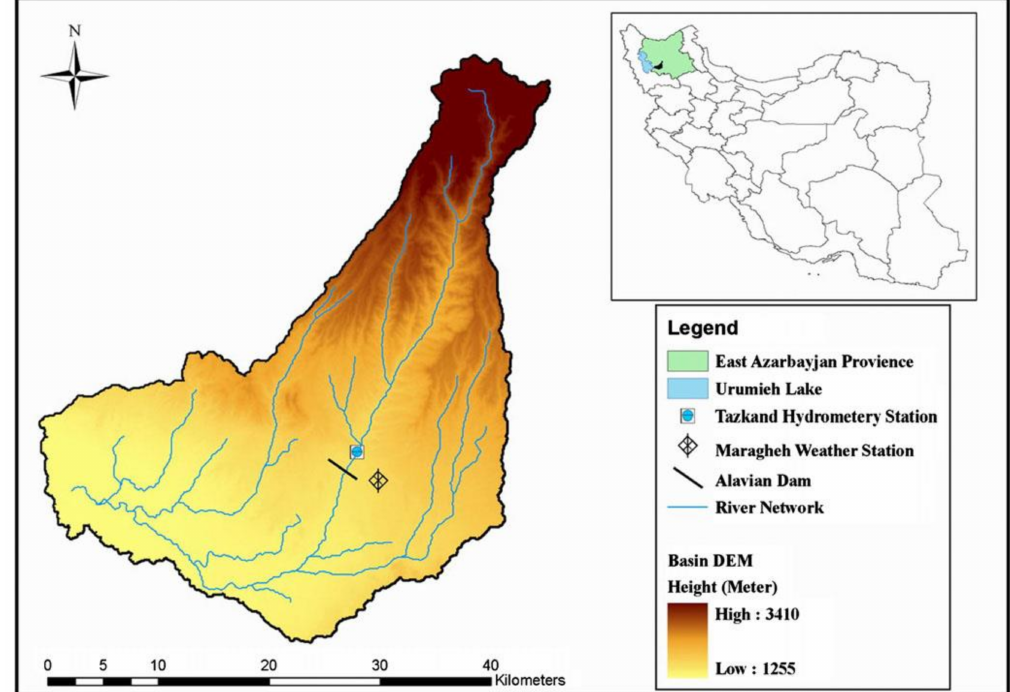
Figure 4. Map of the Alavian River